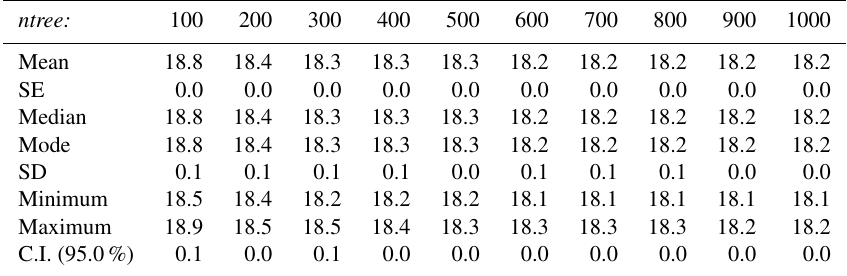
Table B2. Descriptive statistics of MSR from a different number of the ntree parameter, after 10 iterations with 80% of the sample as training data and mtry = 3.